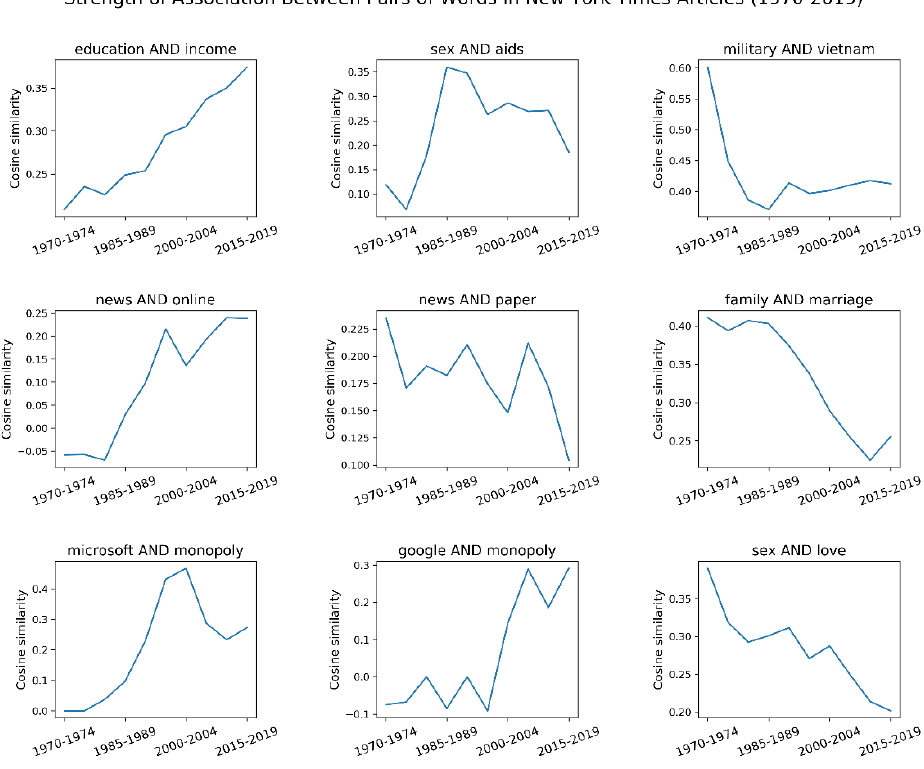
Fig. 4. Strength of association between word pairs in a diachronic corpus of NYT